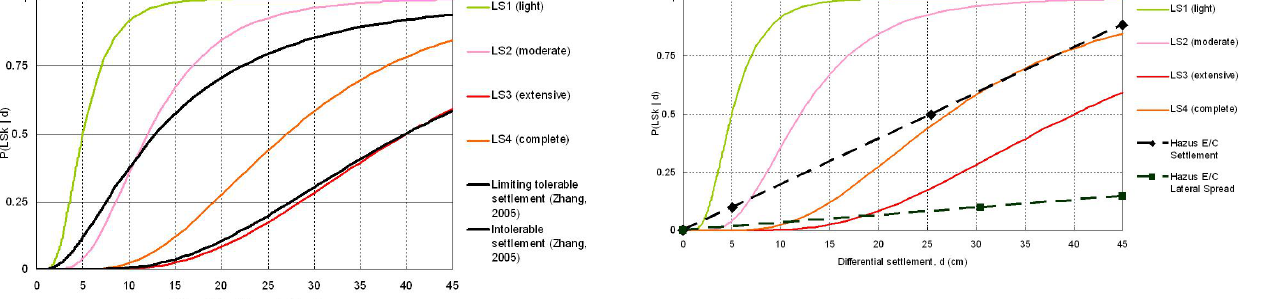
Fig. 11. Comparison between the proposed analytical fragility curves and the building damage functions to Permanent Ground Displacement (PGD) for shallow foundations, as proposed by HAZUS (2003) 1 . Table 6. Building damage relationship to Permanent Ground Dis- placement (PGD) for Shallow Foundations (adapted from HAZUS, 2003 1 ), for Complete (C) and Extensive (E)